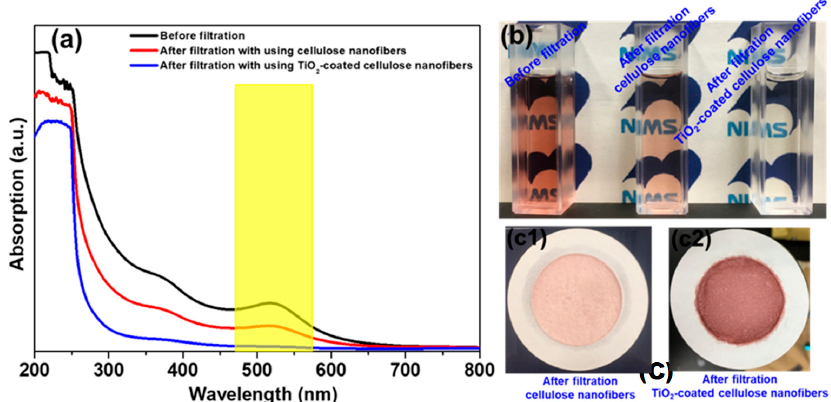
Figure 3. ( a ) UV-vis spectra of the Au colloidal suspensions before and after filtration using uncoated and TiO 2 -coated cellulose nanofibers, and ( b ) their photographs of color appearances in the Au